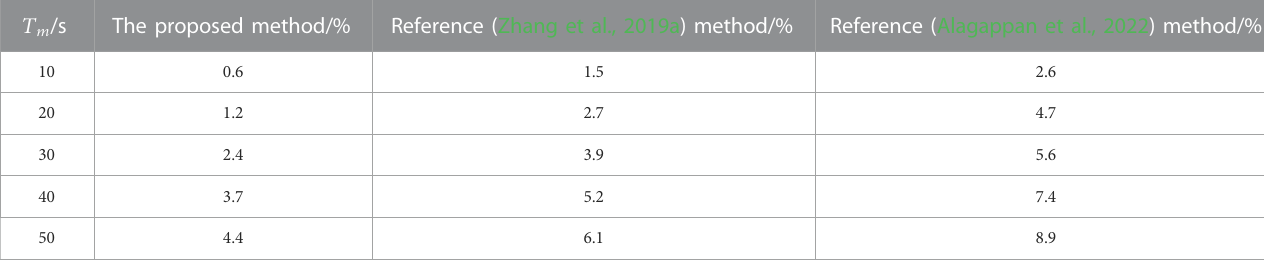
TABLE 2 Comparison results of packet loss rates of different methods. T m /s The proposed